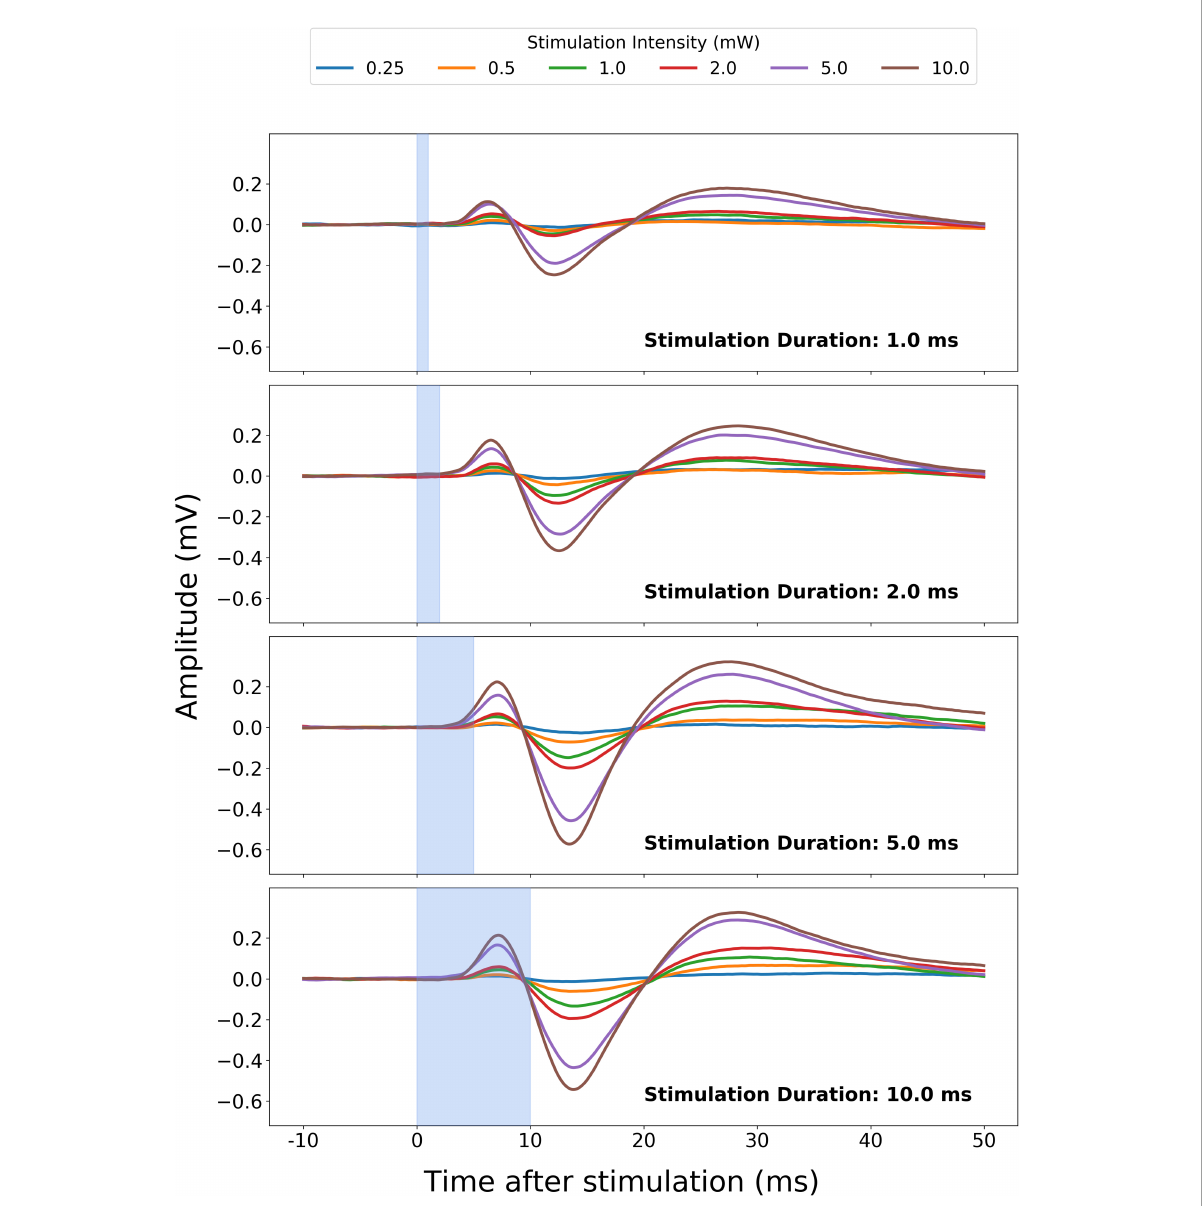
FIGURE2 Transcallosal neural responses in left motor cortex (M1) evoked by contralateral optogenetic stimulation of right M1. Optogenetic excitation of transcallosal projection fibers to contralateral left M1 gave rise to transcallosal evoked potentials in left M1. The mean evoked local field potential (LFP) recorded from one animal (rat27.2, 141 days old, 111 days after surgery), showing an early positive component (P1) and a subsequent negative component (N1). The four panels depict responses evoked with optogenetic stimulation at four different stimulation durations out of seven different durations in total. The different colors correspond to different stimulation intensity